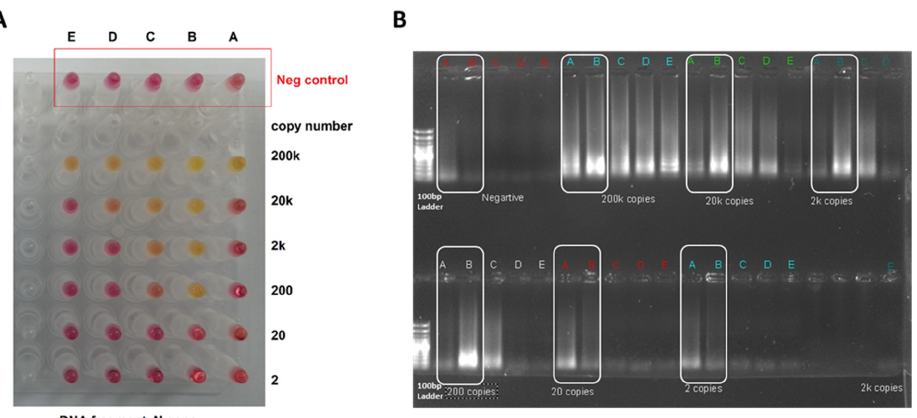
Figure 4. RT-LAMP sensitivity assay on N target using DNA samples. ( A ) The RT-LAMP assay was performed on DNA synthesized fragments. The assay was performed on five primer targets on the N gene (A, B, C, D, and E). The reaction was performed with serial dilution of the N fragment, starting from 200,000 to 2 copies. The reaction was incubated in a heat block at 65 °C for 30 min. ( B ) The gel electrophoresis for the A and B primer targets the N gene. The B primer set has demonstrated a high level of sensitivity to detect 200 copies of the DNA fragment of the N gene.